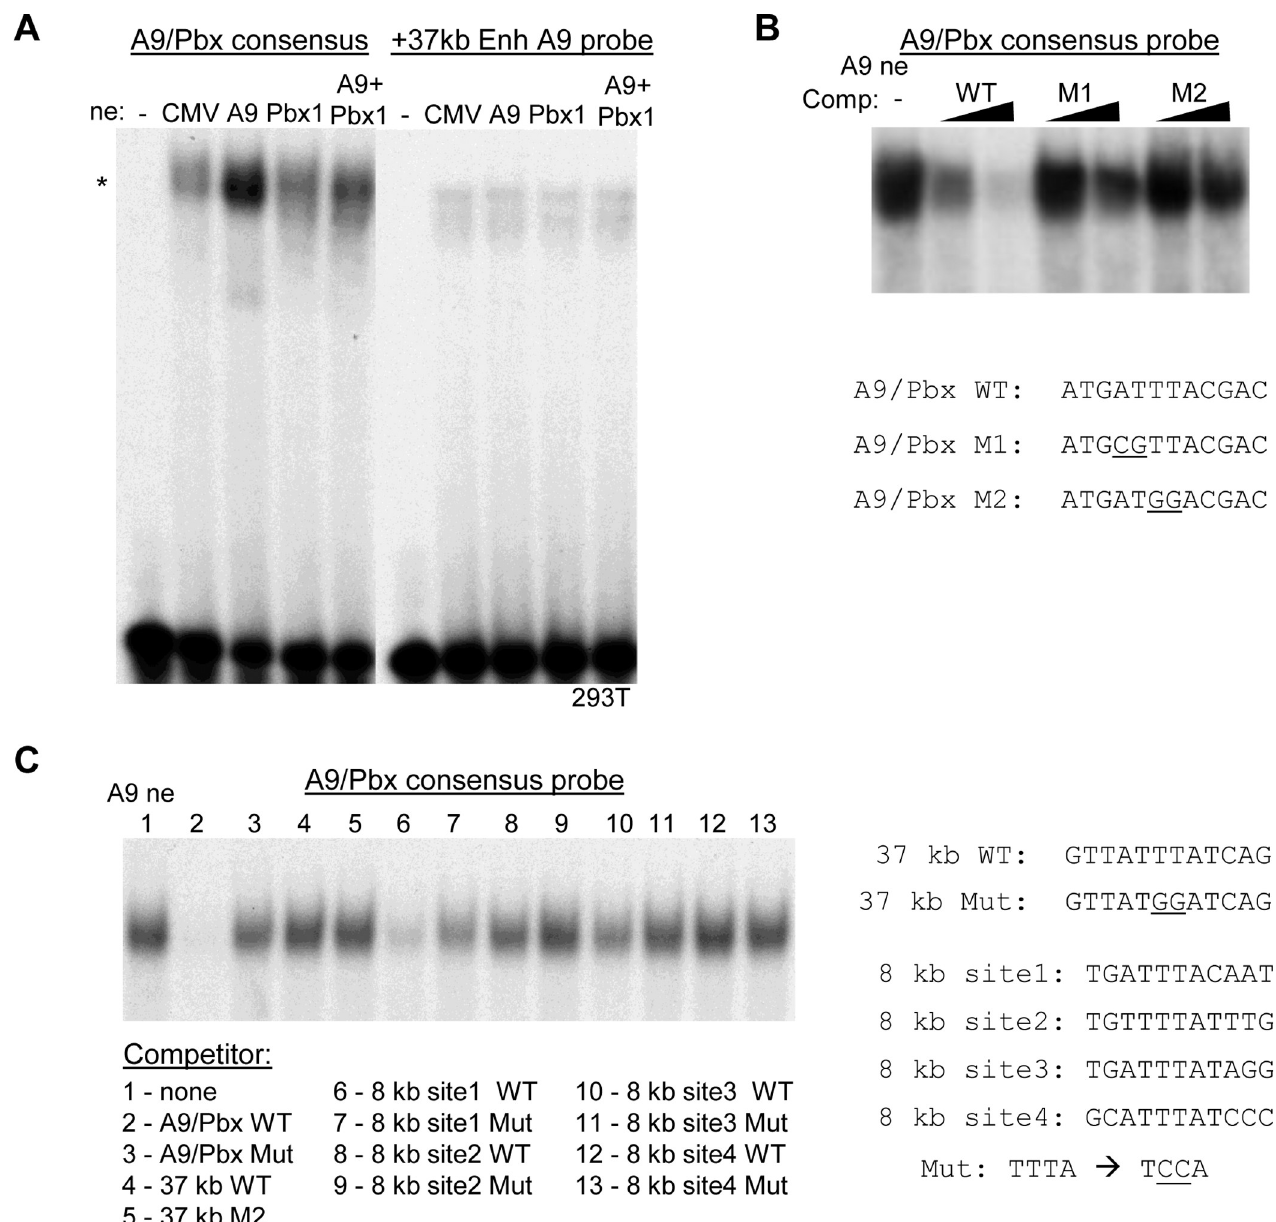
Fig 4. HoxA9 binds three sites within the Cebpa +8 kb enhancer. A) 1 ng of radio-labeled HoxA9 (A9)/Pbx consensus probe or Cebpa +37 kb enhancer HoxA9-binding site probe was incubated with 10 μ g of nuclear extract prepared from 293T cells transfected with empty CMV vector or vectors